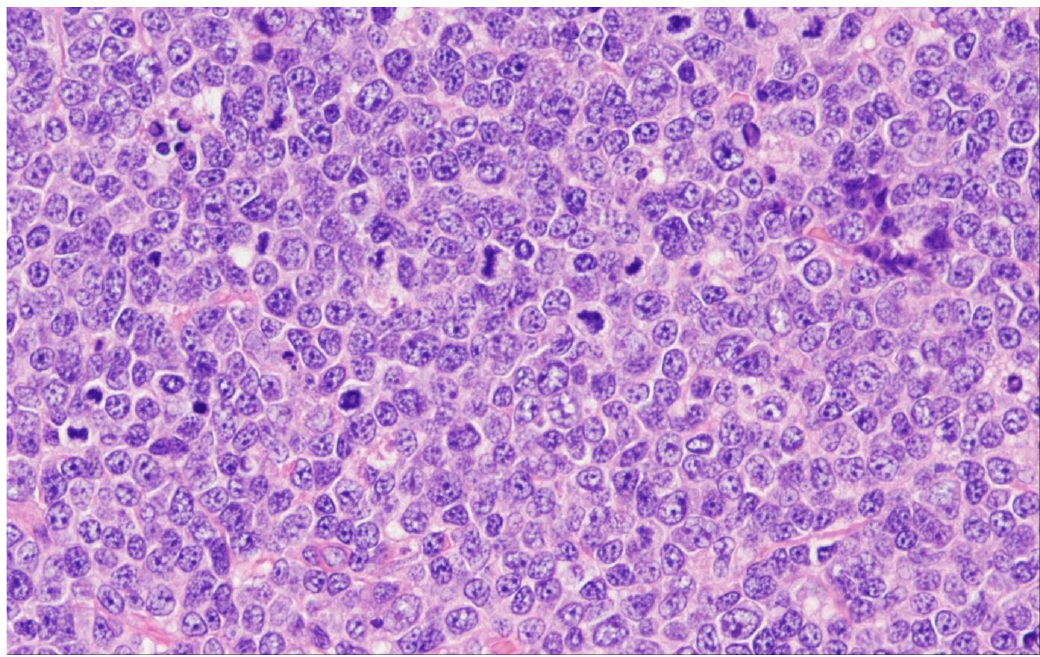
Figure 4. Follicular lymphoma with unusual cytological features (H&E ×400). In this example of a neoplasm growing in follicular structures, there is a predominance of small to medium-sized blastoid cells with round nuclei, finely dispersed chromatin and in part small nucleoli. Note the increased number of mitotic figures. This case had a proliferation index of 80%.